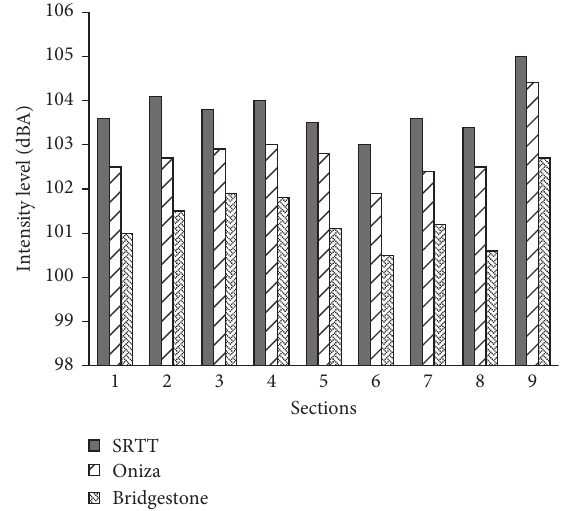
Figure 11: Effects of tire type/size on the OBSI level.